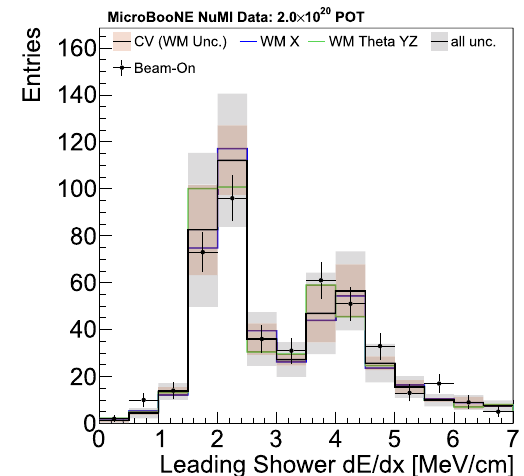
Fig. 11 Distribution of the shower dE / dx using NuMI beam data (points) and central value (CV) simulation (black line). The distribution for the simulation modified based on the detector response as a function of x (blue line) and θ YZ (green line) are also shown. The red band indi- cates the uncertainty from the wire modification alone (with all wire modification uncertainties included). The gray band indicates the full uncertainty, including other detector uncertainties as well as uncertain- ties on the neutrino flux and the interaction model. The bands represent the uncertainty on the number of events in that bin, calculated using Eq. (8), and are symmetric. The error bars on the data are statistical only